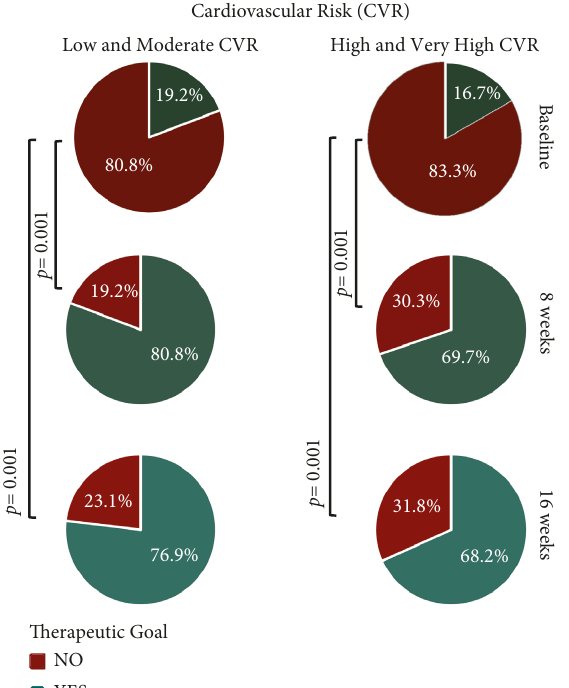
Figure 2: Proportion of patients who met therapeutic goals according to the degree of cardiovascular risk (CVR) at 8 and 16 weeks, compared to baseline. A p value of < 0.05 was taken as statistically significant.